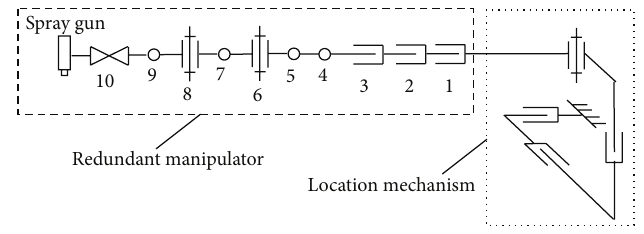
Figure 19: Robot mechanism sketch.